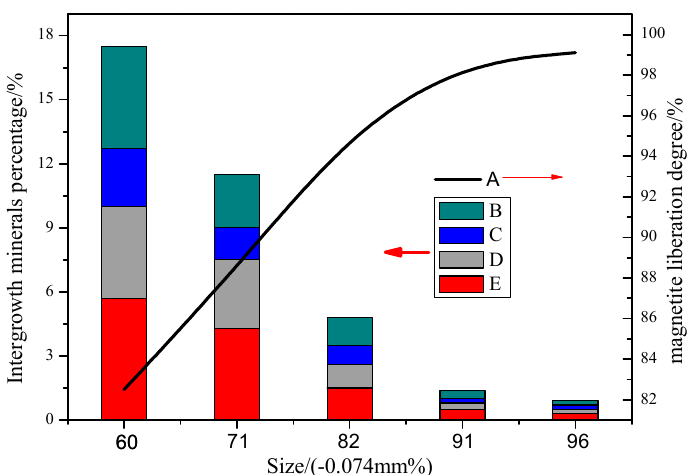
Figure 4. Liberation degree of magnetite within the nickel slag determined by microscopic image measurement method: A—Magnetite free liberation degree; B—The percentage of Intergrowth particles having greater than 75% magnetite; C—The percentage of Intergrowth particles having 50–75% magnetite; D—The percentage of Intergrowth particles having 25–50% magnetite; E—The percentage of Intergrowth particles with less than 25% magnetite.